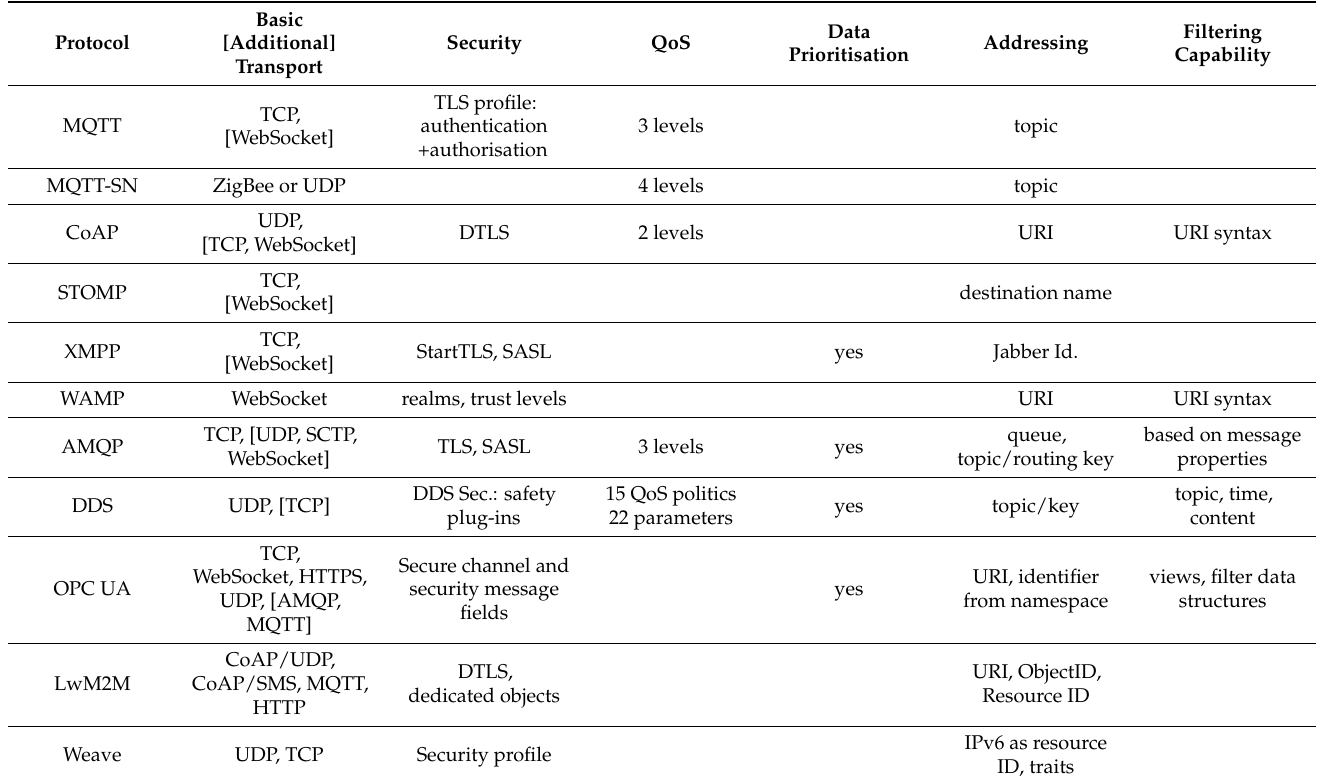
Table 3. Transport